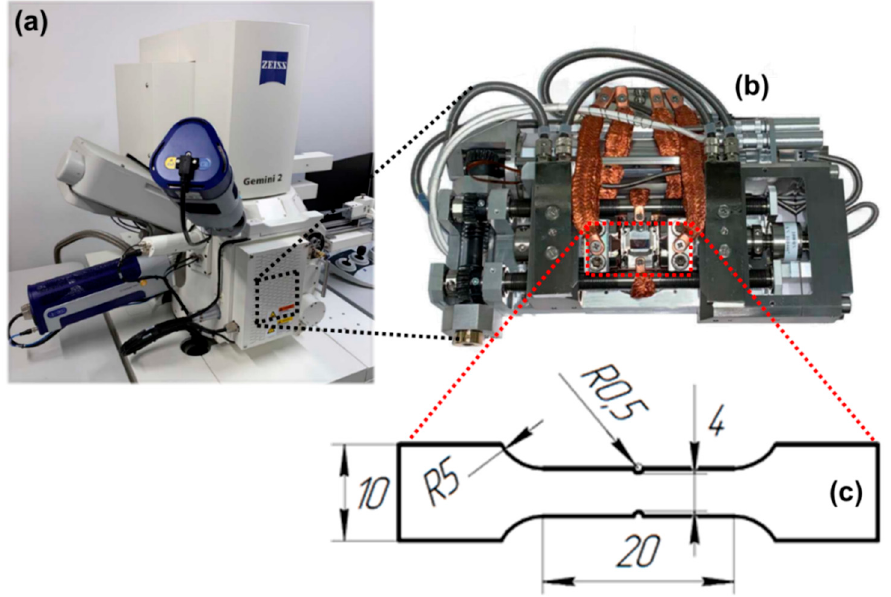
Figure 1. ( a ) ZEISS Gemini SEM 450 scanning electron microscope used ( b ) and the in situ tensile model. ( c ) Geometry of the in situ specimens with notches for the stress concentration, where all the dimensions are in mm. dimensions are in